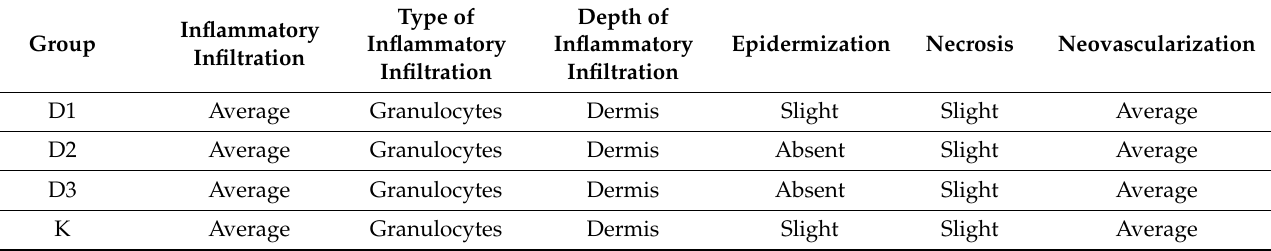
Table 9. Histopathological results from day 10 .